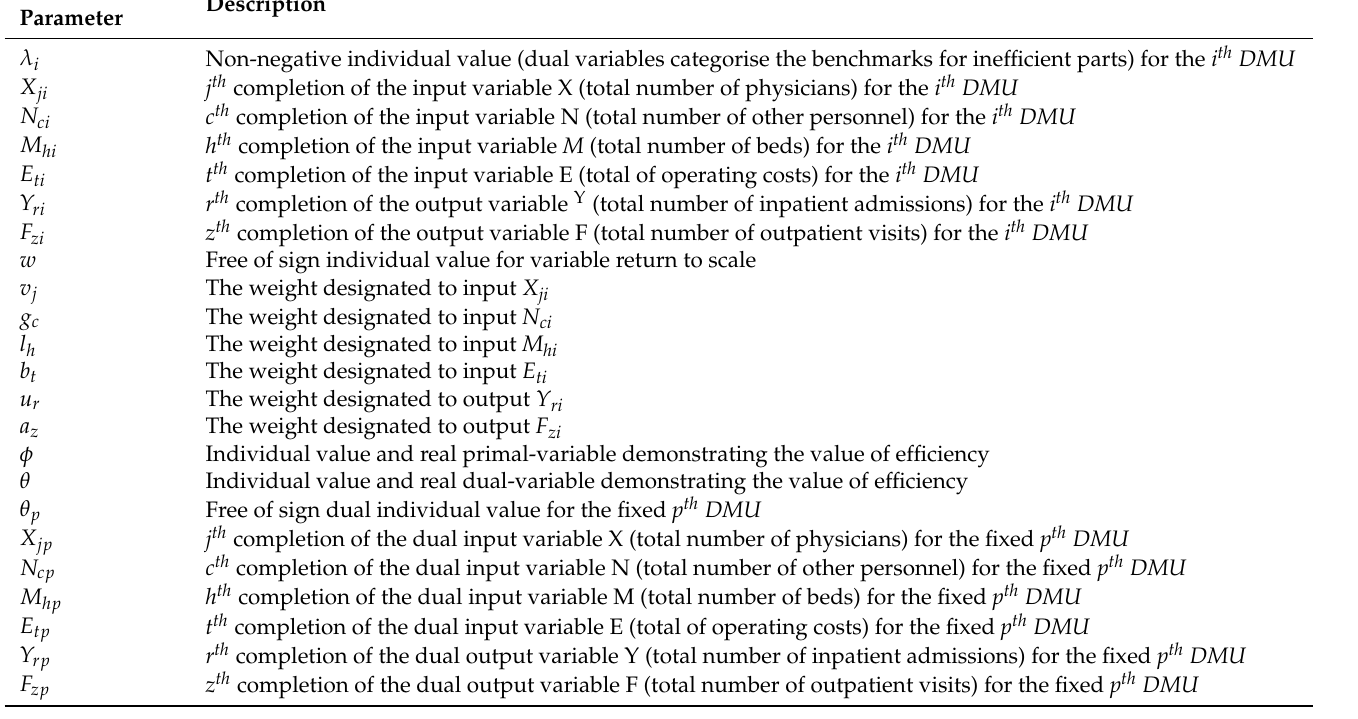
Table 2. Explanation of the parameters for primal and dual BCC IO -CCR IO